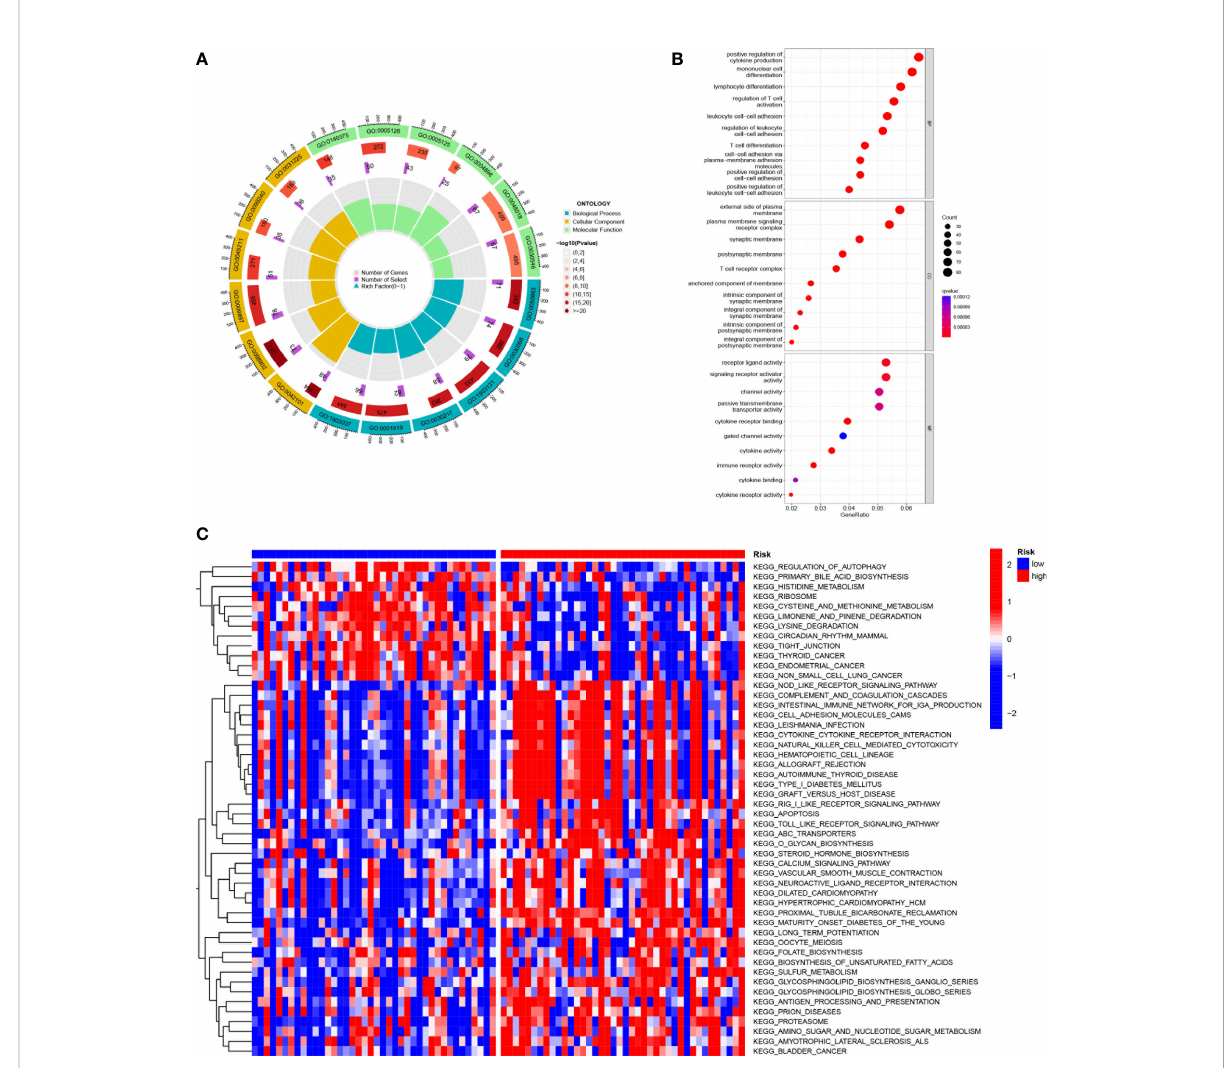
FIGURE 6 Functional enrichment analysis of SMGs in TCGA-UVM. (A, B) Gene Ontology (GO) enrichment analysis was used to analyze the differential genes between UVM and normal samples. The x axis represents the ratio of genes associated with the term, and the y axis represents the pathway term. The p value of each item is colored according to the legend. (C) GSVA analysis between the high-risk cohort and the low-risk cohort with